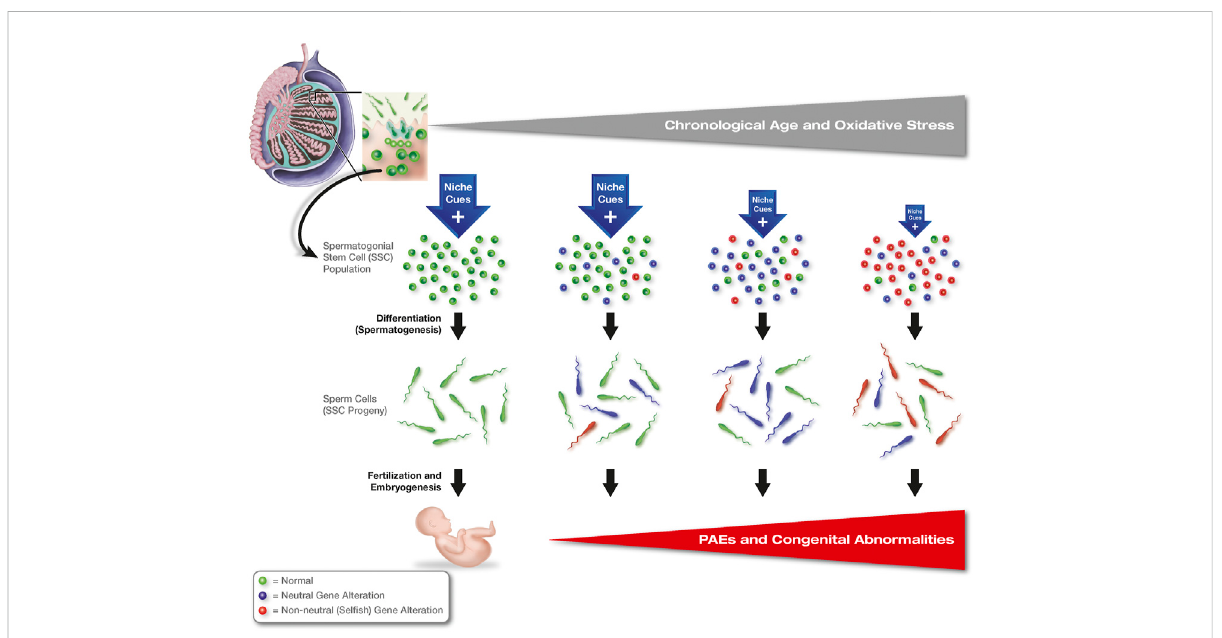
FIGURE 1 Clonal heterogeneity and non-neutral selection in adult stem cell populations: sel fi sh selection in SSCs. Genetic alterations occur randomly within individual SSCs with age, most of which are neutral or silent (blue-shaded cells); however, some mutations lead to disruptions in FGFR/RAS/ MAPK signaling in affected clones (sel fi sh mutations, red-shaded cells), which enable survival and growth of these stem cells independent of niche- derived signals normally needed by SSCs to function. As support from the niche deteriorates with age, SSC clones with neutral mutations that arestillreliantonsignalsfromthenichearelostandreplaced withSSCsharboringgeneticalterationsthat conveynicheindependence, leadingtoan expansion of these clones across the population as other clones lacking advantageous mutations progressively die off. While these latter mutations are advantageous to the selected stem cell clones, spermatozoa produced by these SSCs carry the same mutations into eggs at fertilization, leading to a spectrum of developmental abnormalities, or paternal age effects (PAEs), associated with aberrant FGFR/RAS/MAPK signaling during